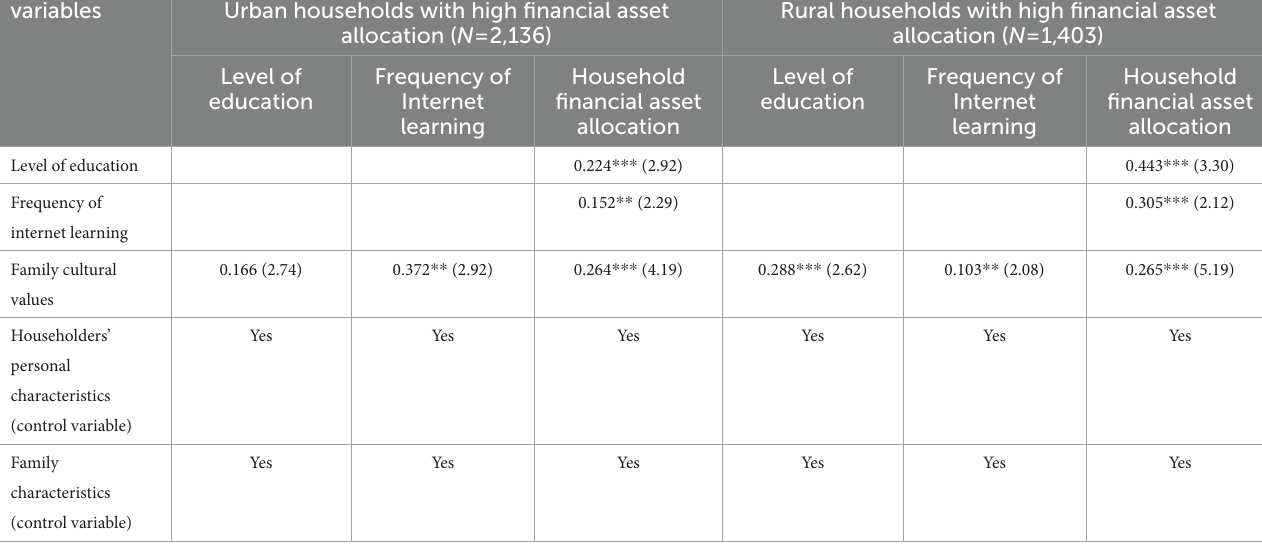
TABLE 4 Mediating effect of knowledge acquisition in high households financial asset